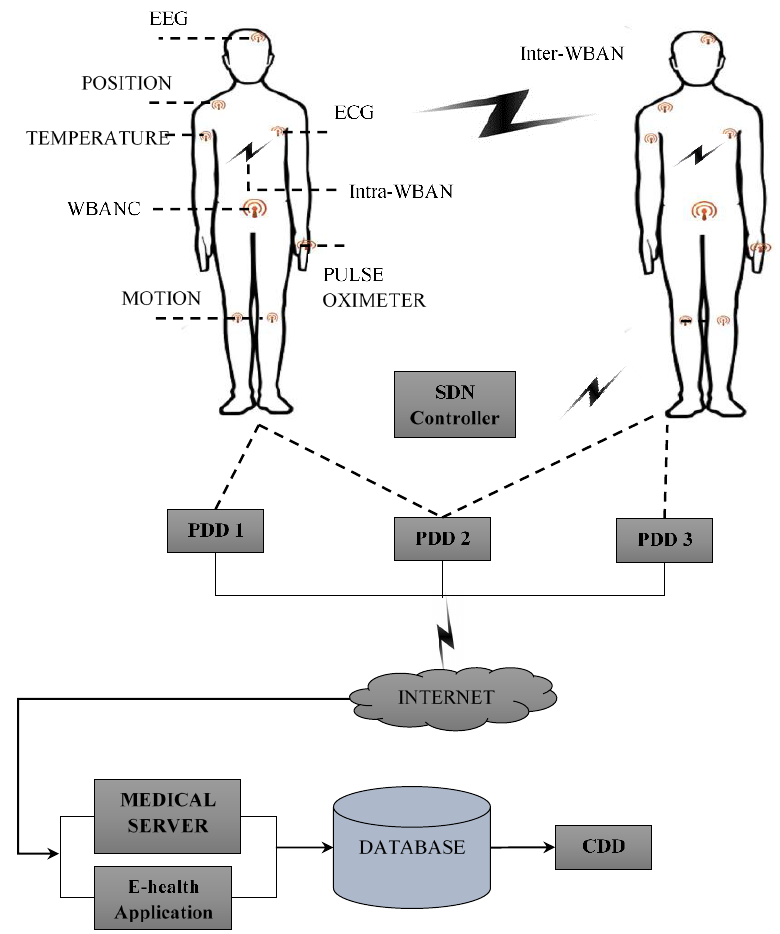
Figure 1. Architecture of proposed SDN-based WBAN system.